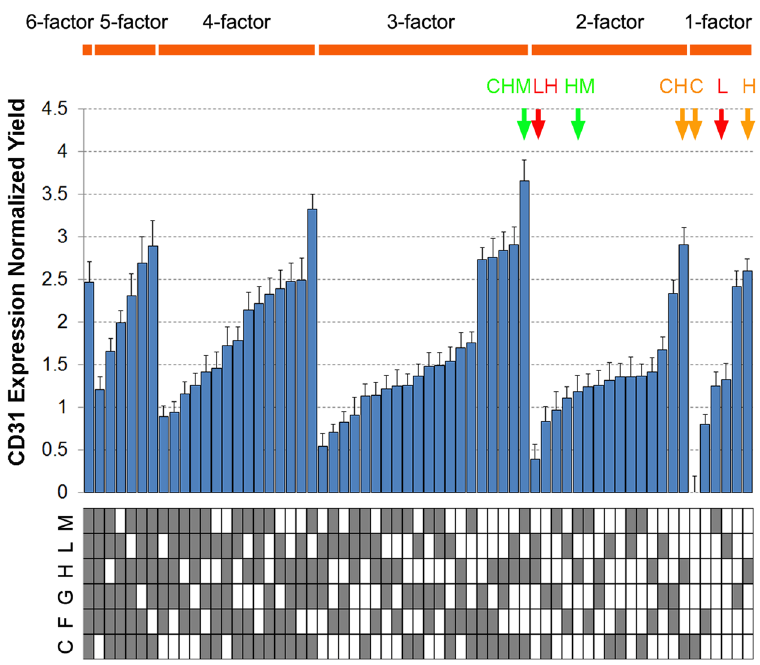
Figure 4. Non-additive interaction effects among ECM combinations on endothelial differentiation. Based on the CD31 expression data generated from iPSCs (HUF5, n = 5), iPSCs (DOX1, n = 3) and ESCs (H1, n = 5), examples of synergistic, inhibitory and redundant interactions were labeled in green, red, and orange respectively. Green: C + H + M (3.66 ± 0.25) indicates a synergistic effect as C (0 ± 0.19) and H + M (1.18 ± 0.19) had a lower CD31 expression score, compared to the three combined. Red: L (1.33 ± 0.19) and H (2.60 ± 0.14) showed inhibitory effect as L + H (0.39 ± 0.18) resulted in much lower CD31 expression than each individual ECM. Orange: C (0 ± 0.19) and H (2.60 ± 0.14) showed a redundant effect as CD31 expression on C + H (2.91 ± 0.20) was similar to that on H